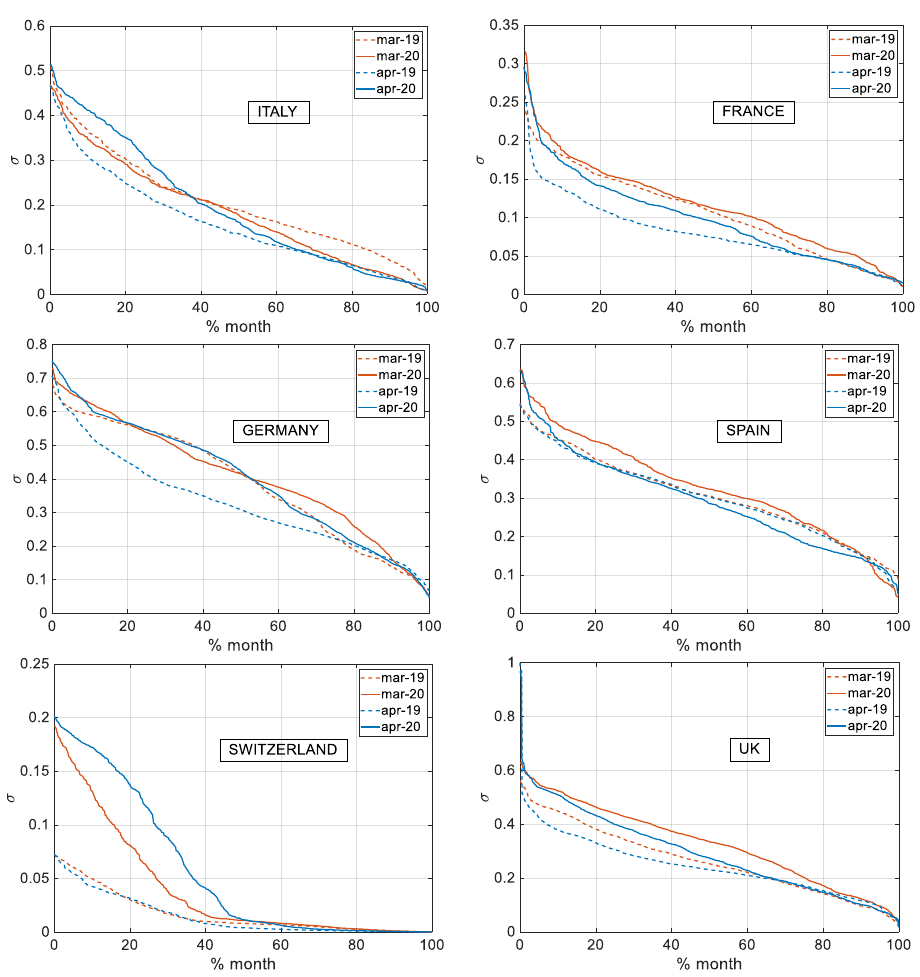
Figure 7. Duration curves of non-conventional penetration index for a selected number of countries.